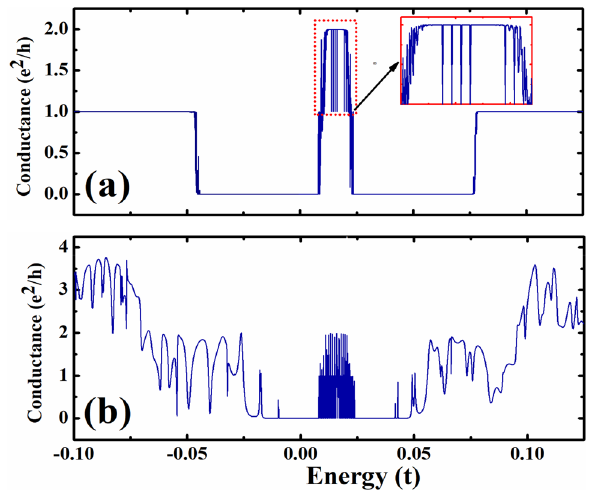
Figure 3. Conductance of the device with two nanoscale constrictions plotted as a function of energy. ( a ) Both magnetic and electric fields are considered in the device with the parameters φ = 0.0015 and eE y = 0.001 t /nm . ( b ) Only electric field is considered with the parameters φ = 0 and eE y = 0.001 t /nm .